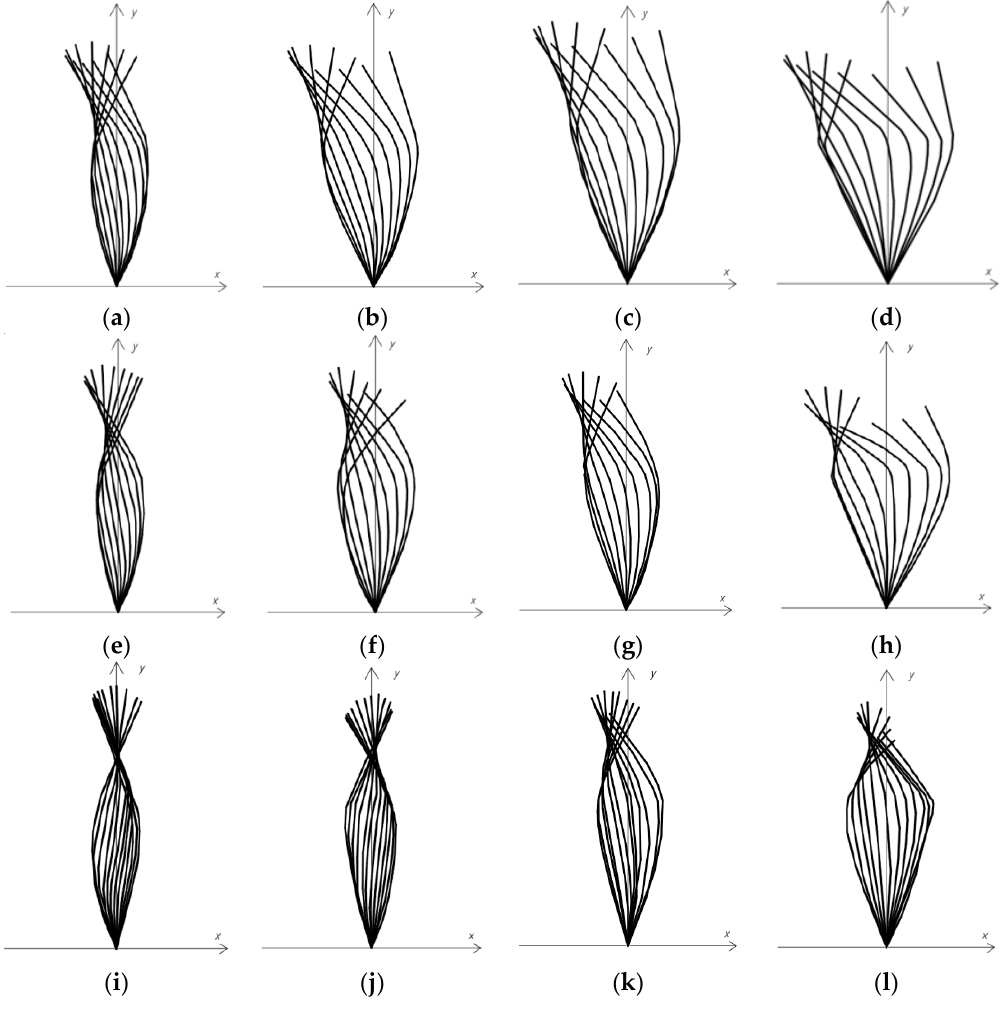
Figure 9. The swing curves of fishtails with different stiffnesses in half cycle at 0.5 Hz, 0.8 Hz, and 1.2 Hz. Each picture depicts the posture of the fish’s tail swinging in a half cycle frame by frame in a rectangular coordinate system. Among them, ( a – d ) corresponds to four kinds of gradually increasing stiffnesses at 0.8 Hz, ( e – h ) corresponds to four kinds of gradually increasing stiffnesses at 0.5 Hz, and ( i – l ) corresponds to four kinds of gradually increasing stiffnesses at 1.2 Hz. It can be seen in Figure 10 that with the increase of the rate of change of the fishtail